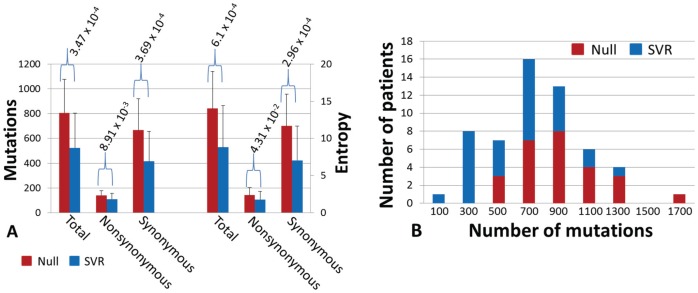
Comparative analysis of the mutation load, either average number of mutations per patient (left side) or normalized entropy (right side), between SVR and null response groups (A).The analysis was done with either synonymous, nonsynonymous or the combination (A). The histogram of total mutation number, fitting a Poission distribution, gave a more intuitive observation with respect to its relevance to the outcomes of HCV antiviral therapy (B).